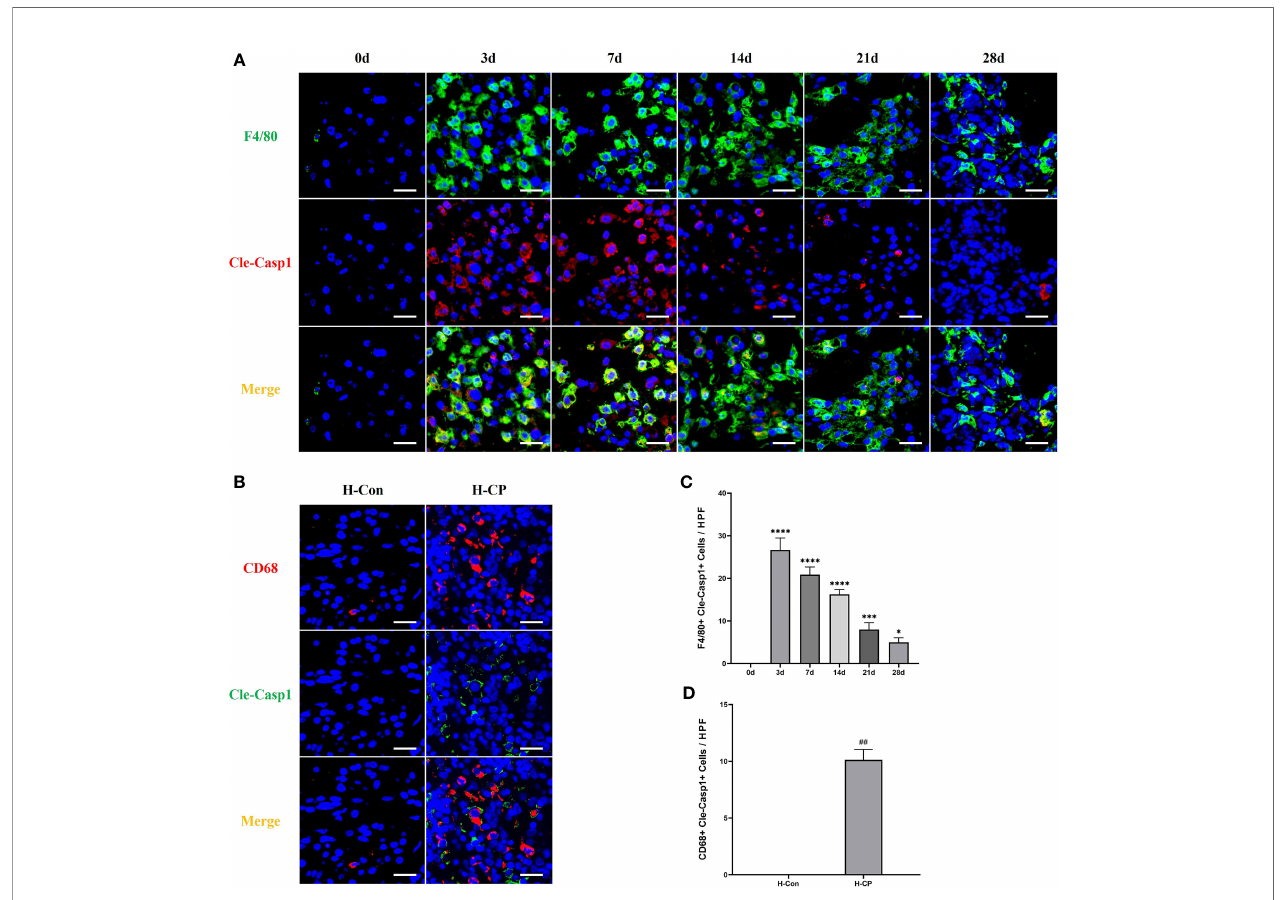
FIGURE 6 | Pyroptotic macrophages (F4/80+Cleaved-Caspase1+cells) were observed more in AP, which decreased over time in CP. (A) Immuno fl uorescence staining of pancreatic pyroptotic macrophages in mice model of pancreatitis at different time points. (B) Immuno fl uorescence staining of pancreatic pyroptotic macrophages in human specimens. (C) Pancreatic pyroptotic macrophages counts per HPF in mice. (D) Pancreatic pyroptotic macrophages counts per HPF in human specimens. Values are shown as means ± SE. n = 3 per group. *P < 0.05, ***P < 0.001, ****P < 0.0001 versus 0d. ## p < 0.01 versus H-Con. Scale bar=20 m m. H-CP, human chronic pancreatitis; H-Con, human control; HPF, high-powered fi eld of